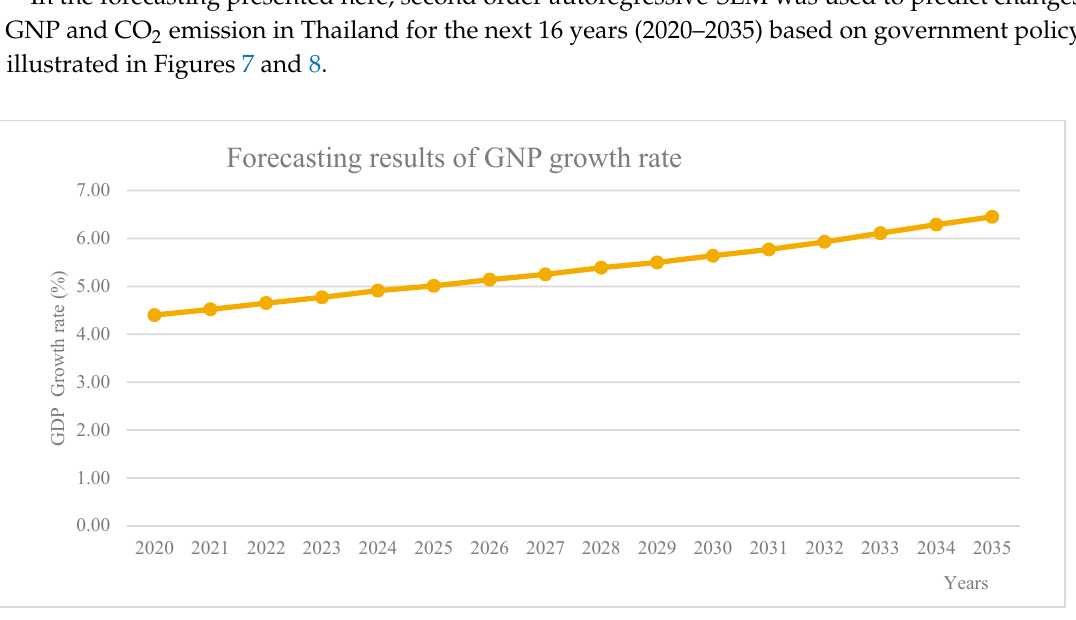
Figure 8. The forecasting results for CO 2 emission from 2020 to 2035 in Thailand . 5. Conclusions and Discussion This research proposes the adoption of second order autoregressive-SEM by using advanced statistics to analyze the influential magnitude of causal relationships, and to forecast such influence on economic and environmental factors under the Industry 4.0 policy imposed by the federal government of Thailand. The software utilized in the analysis was LISREL, which is the most suitable software for this type of advanced statistics. This research was carried out through application of research principles considering the characteristics of the causal factors in establishing a long-term forecasting model. In choosing all causal factors for this model, only identified actual causal factors were taken for analysis by ensuring each factor become stationary at the first difference, while all variables were co-integrated at the same level. The variables are national income ( ln(NI) Δ